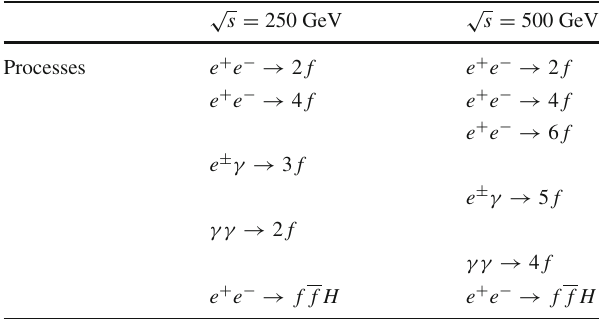
Table 2 List of MC samples used in this analysis